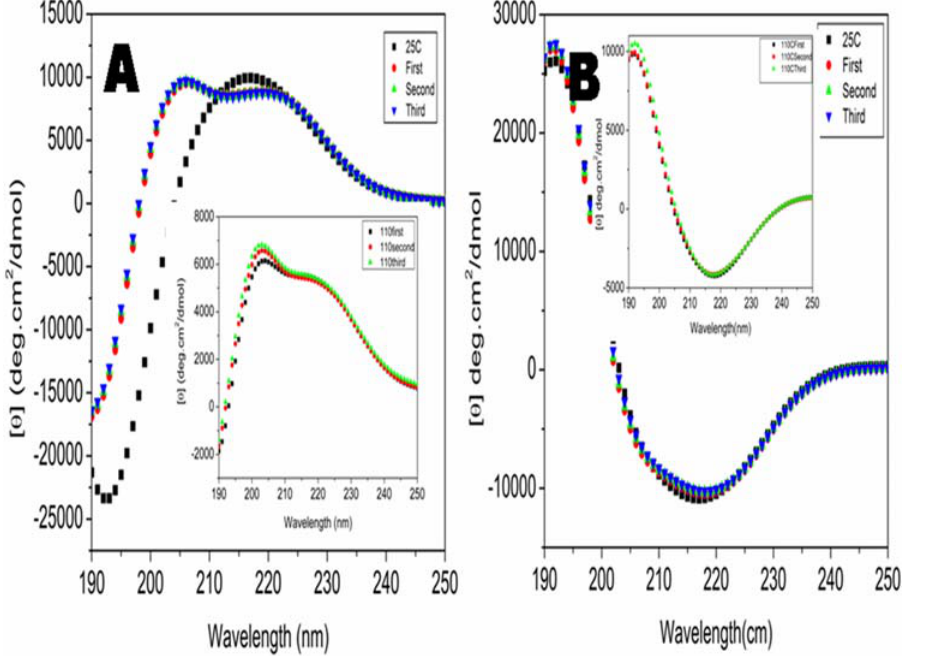
Figure 5. Temperatures induced d-EAK16 and l-EAK16 structural transition. d-EAK16 and l-EAK16 were incubated at 110 u C and cooled to 25 u C and the cycles were repeated 3 times. A) The d-EAK16 formed stable beta-sheets when measured at 25 u C. The d-EAK16 underwent two-phase transitions when elevated at 110 u C, from beta-sheet to alpha-helix. The figure insert is the time-dependence of d-EAK16 structural transition. The structural transition occurred in 3 stages. After first incubation, the beta-sheet became less stable and showed signs of structural change. After second incubation, it abruptly converted from a beta-sheet to an alpha-helix. After third and prolonged incubation, no significant change for alpha- helix was observed. B) The l-EAK16 stayed as a stable beta-sheet. No abrupt structural transition was observed for l-EAK16 even when temperature was elevated to 110 u C. The insert is the time-dependence of l-EAK16 structural transition.